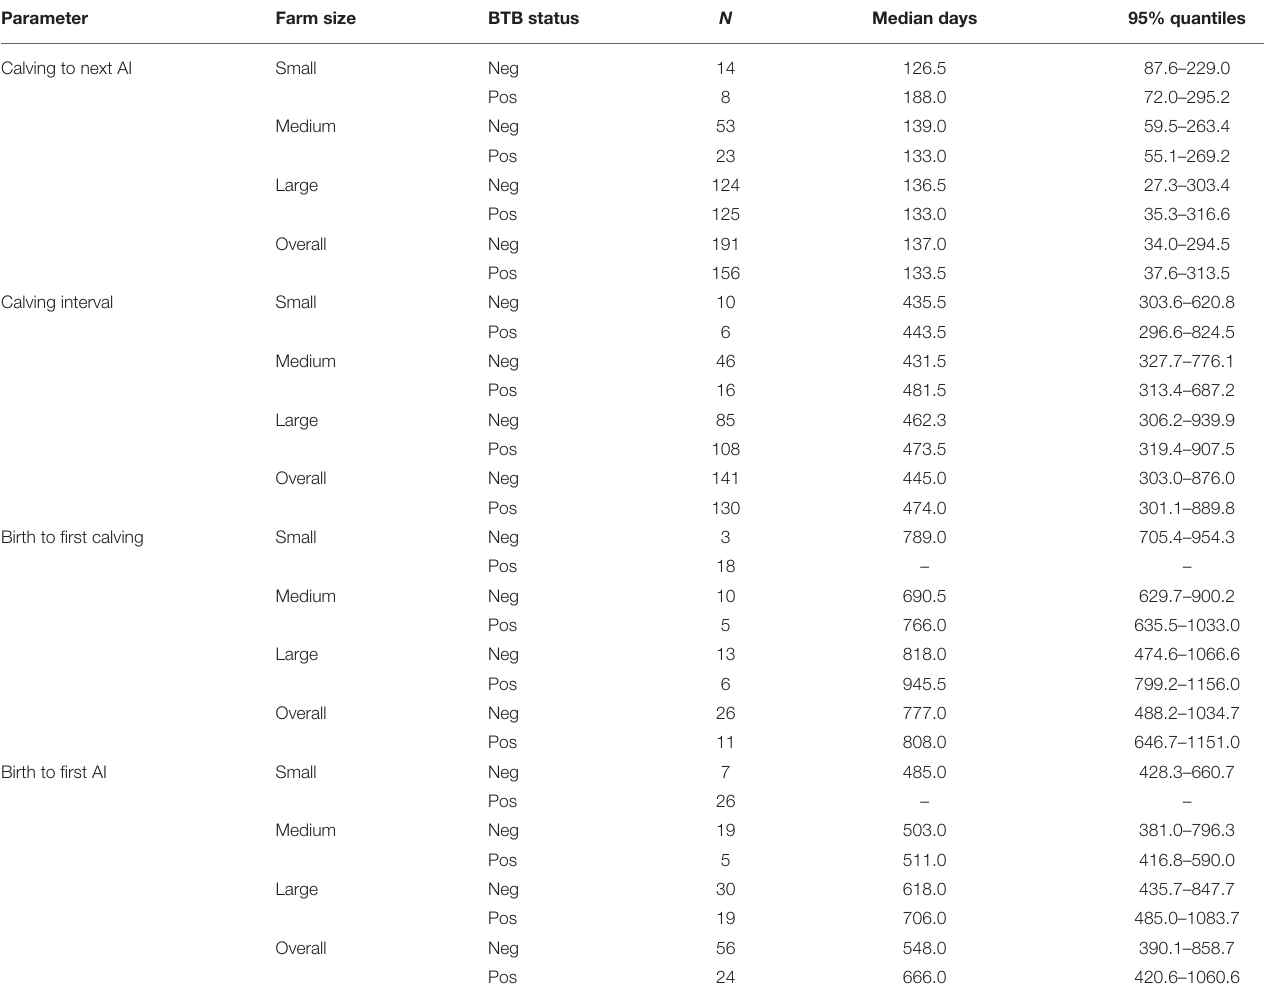
TABLE 2 | Description of fertility parameters by farm size and BTB